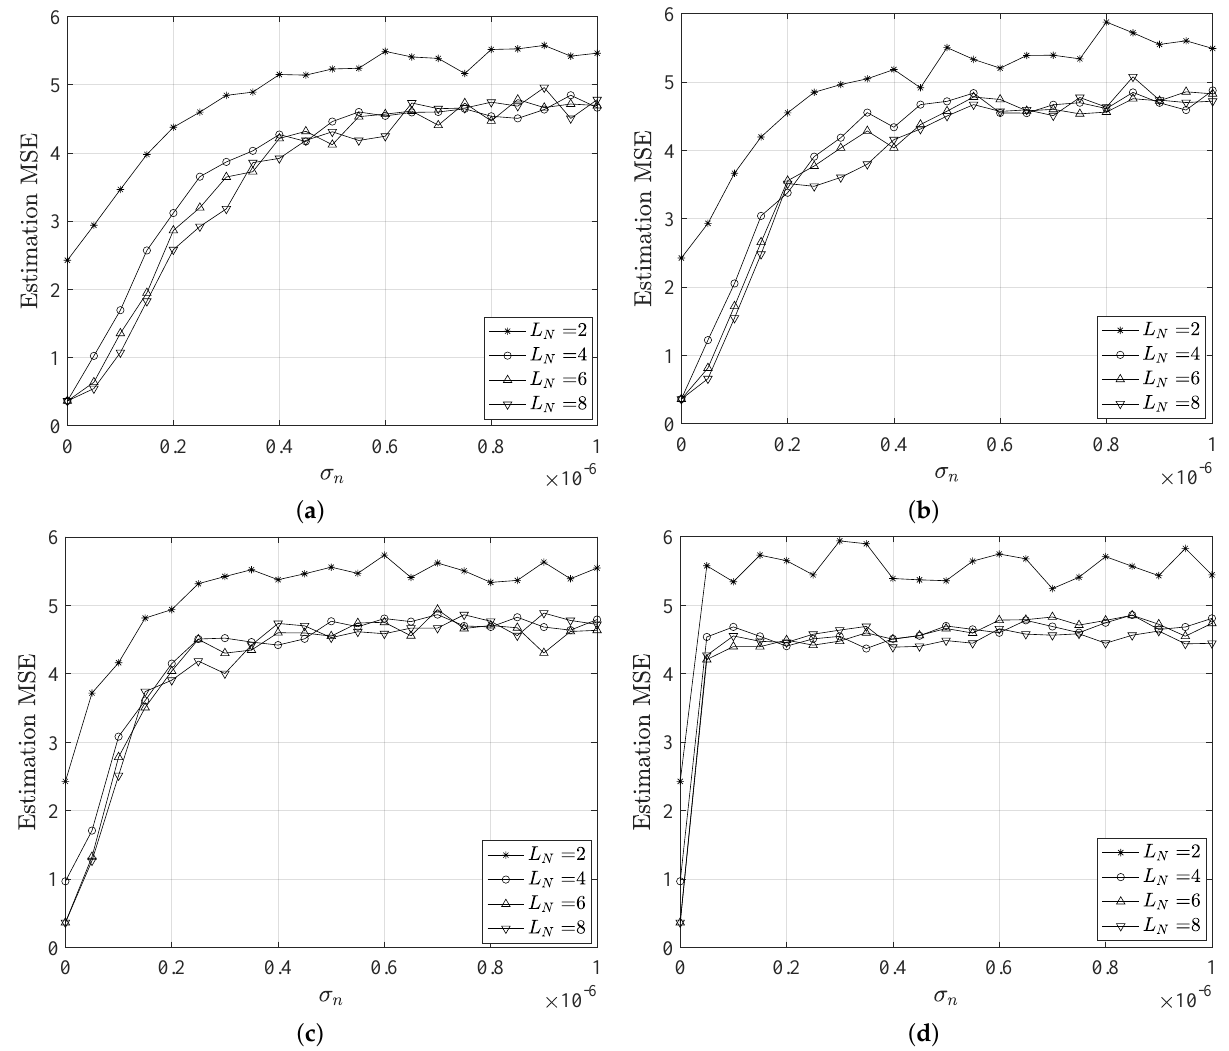
Figure 4. MSE of the position estimation behavior versus the noise standard deviation for different network configurations and water types, i.e., ( a ) pure, ( b ) clear, ( c ) coastal and ( d ) harbor water. We assume a beam angle of 80 ◦